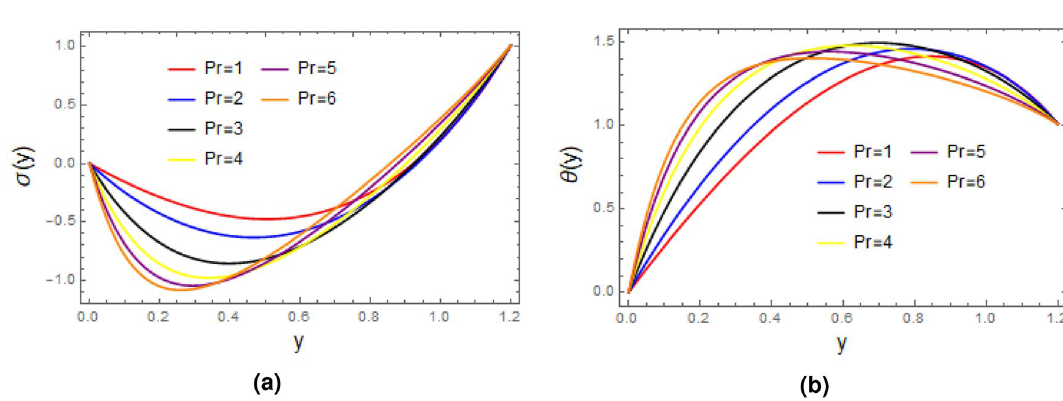
Figure 8. Plots of ( a ) concentration σ and ( b ) temperature θ for Prandtle number with α = 1 , ε = 0.2 , δ = 0.1 , F = 0.5 , x = 1 , Ec = 1 , N t = 1 , ζ = 0.01 , N b = 0.8